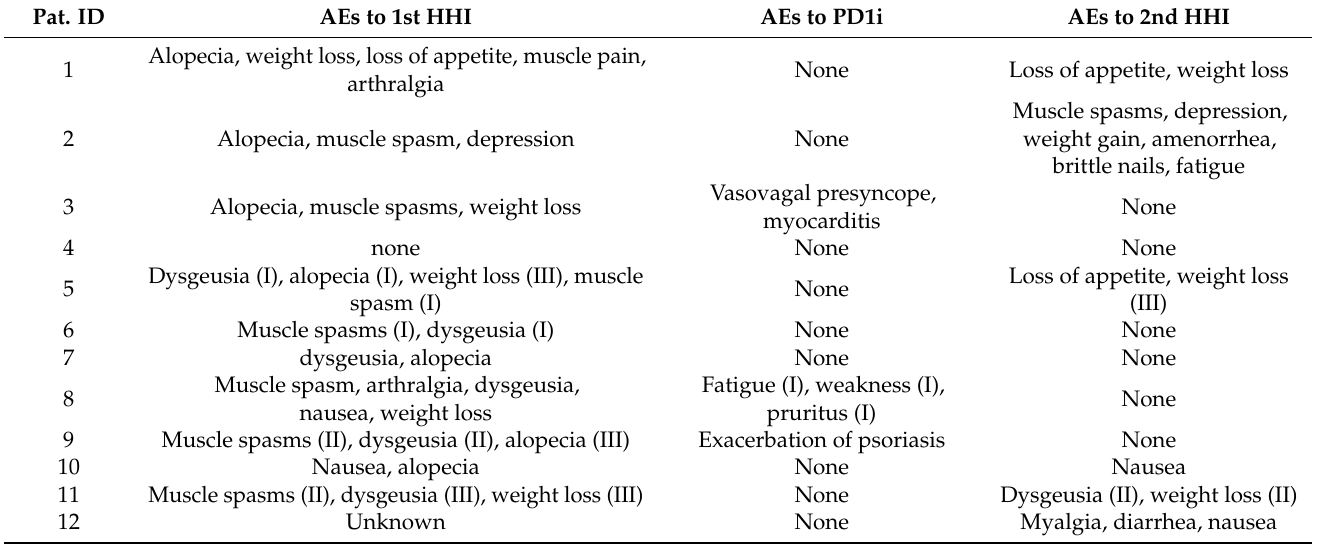
Table 3. Sequence of adverse events to therapy sequence; severeness grades (according to CTC-AE version 5.0) are given in brackets, if